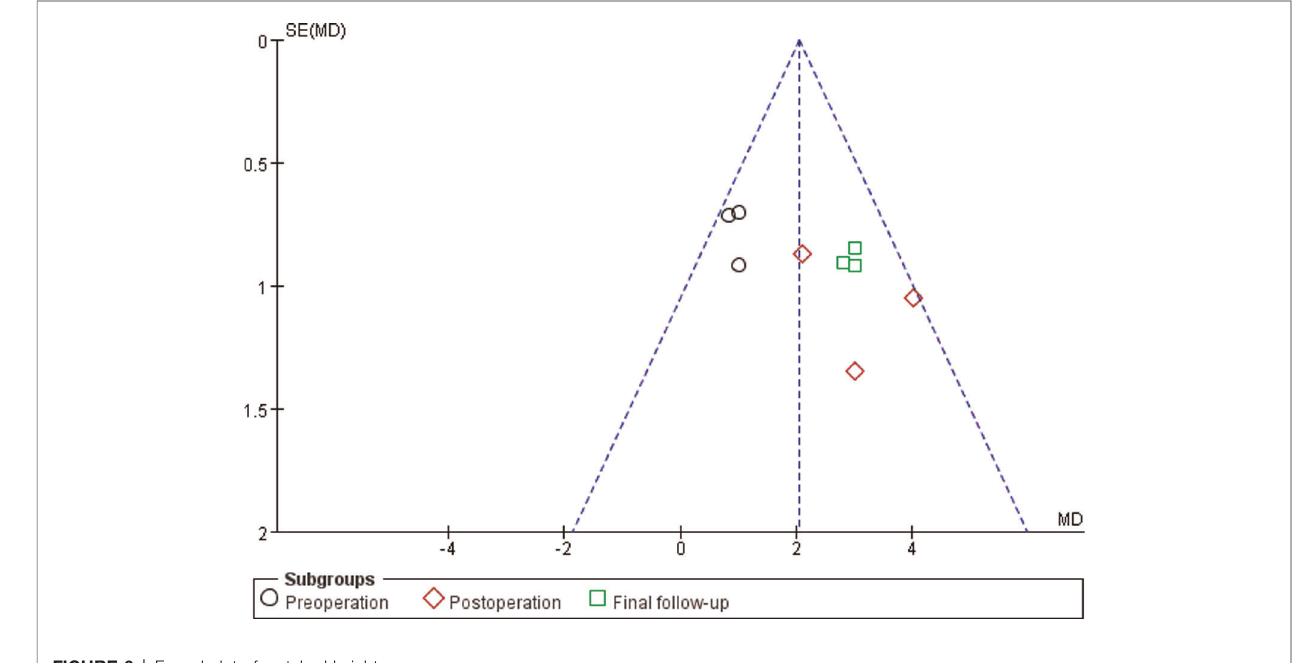
FIGURE 6 | Funnel plot of vertebral height.